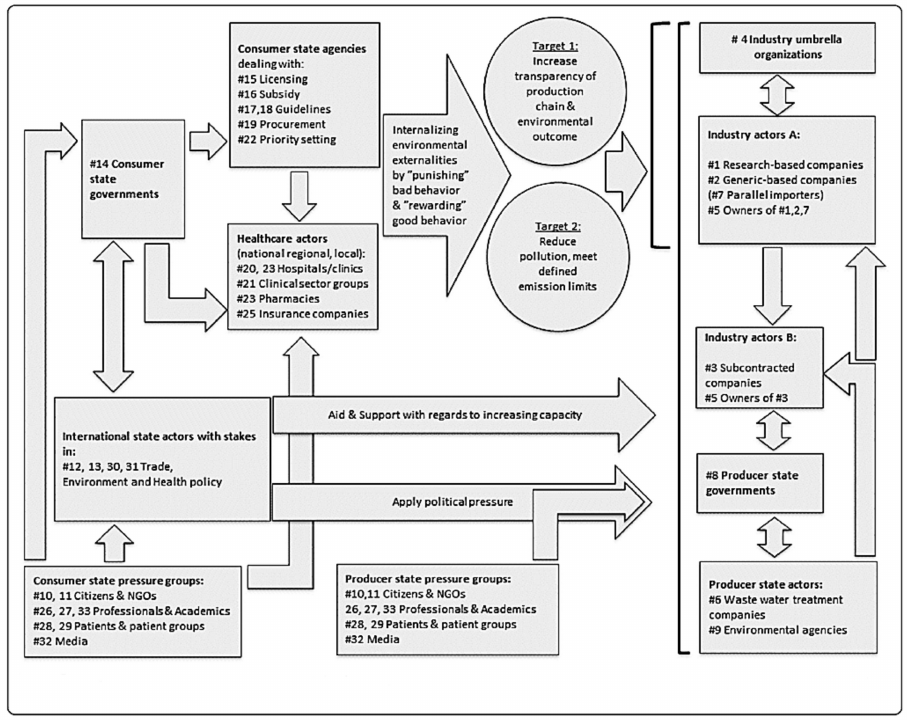
Figure 3. Examples of the chains of actions of different actor types to incentivize the action of other actors to improve the management of environmental–industrial antibiotic pollution. Reproduced with permission from Nijsingh, Niels et al.